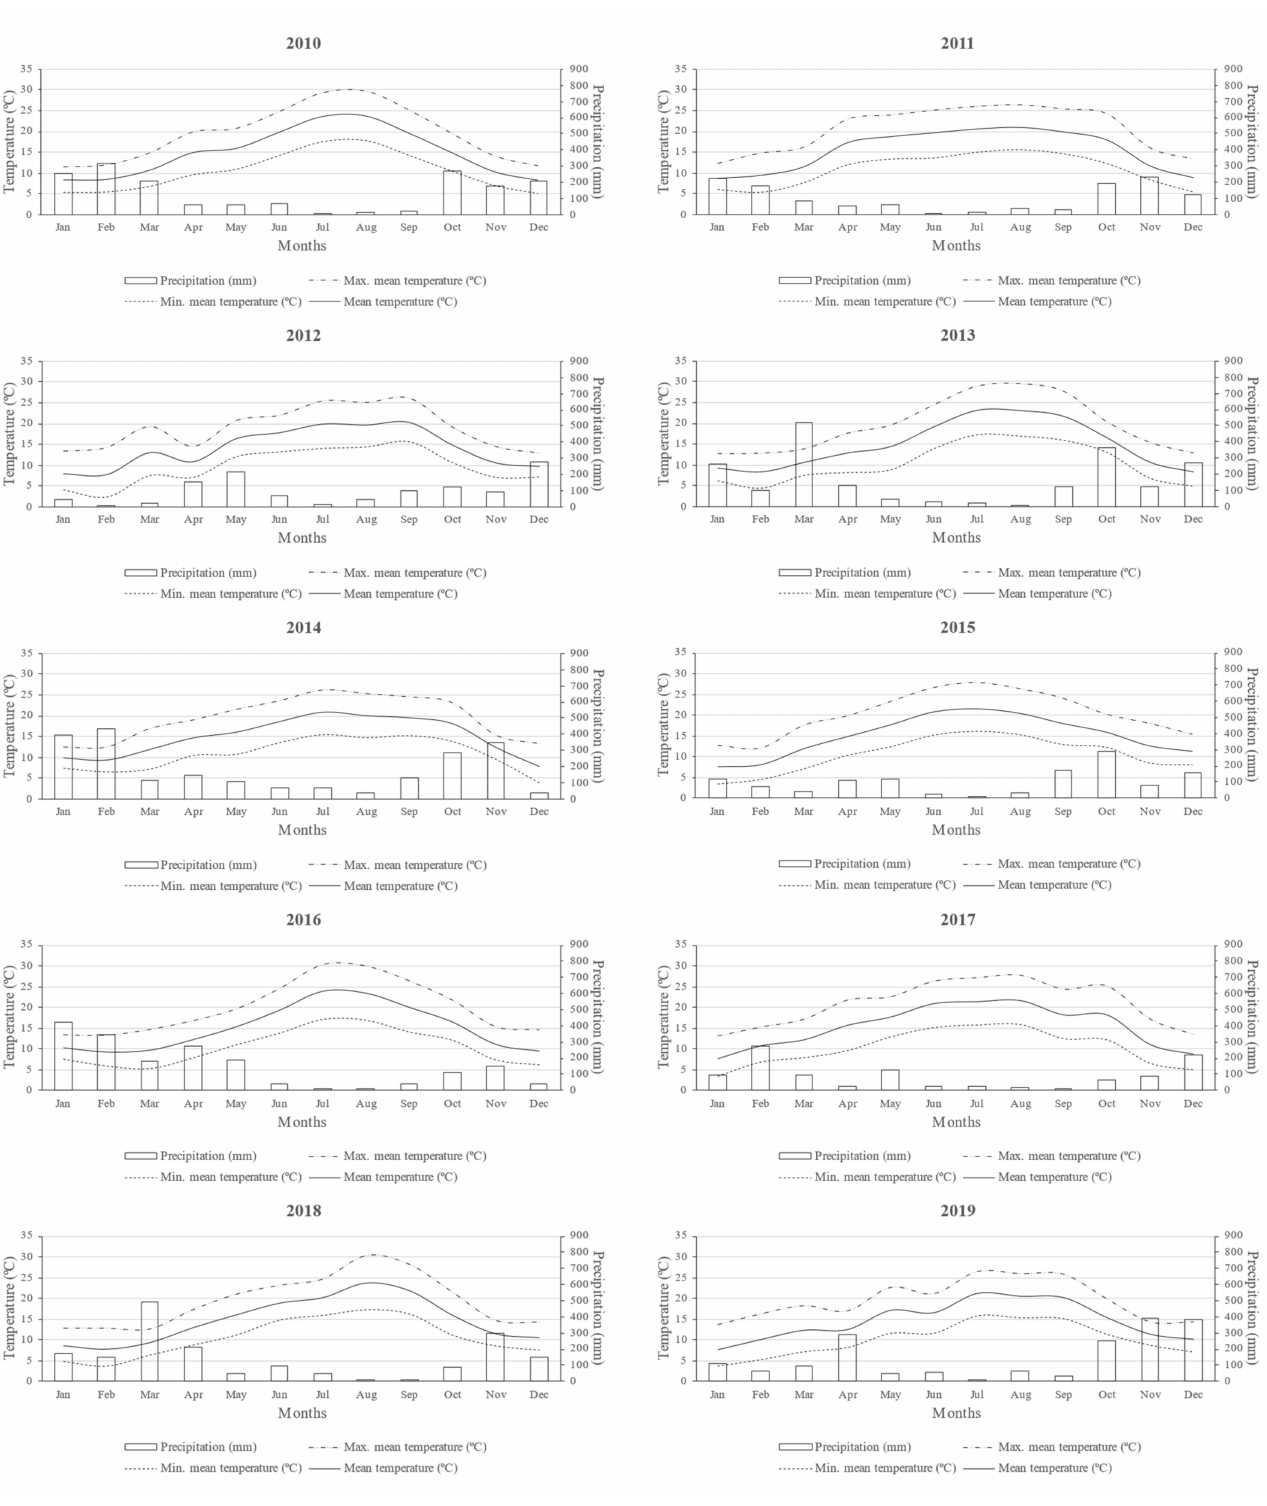
Figure 6. Distribution of climatic parameters for the decade of